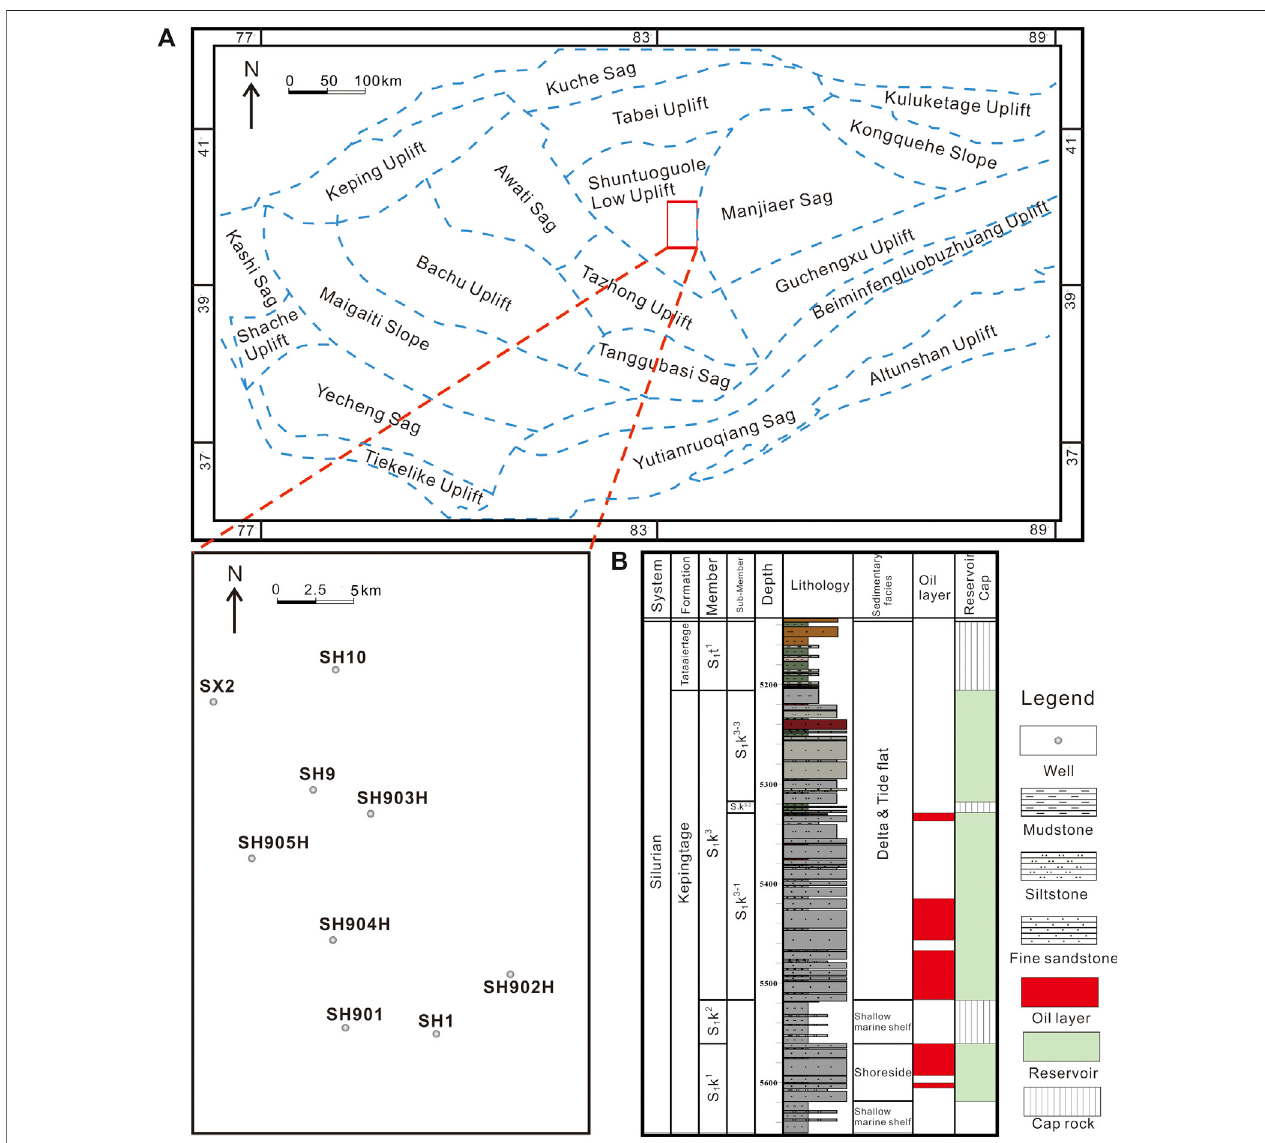
FIGURE 1 | Structural location and well location distribution in the study area. (A) Location of Shuntuoguole low uplift and surrounding structural features. (B) Lithological pro fi le and reservoir-caprock assemblage of Kepingtage Formation (S 1 k 1 , totally 90 ～ 150m thick shoreside (non-barrier coast)-shallow marine shelf facies deposit that is different from common high-energy shoreside due to low-energy water body, mainly consists of fi ne-grain sandstone with medium-grain sandstone and siltstone in the upper part and mudstone in the lower part. S 1 k 2 , 43 ～ 59m thick, deposited in the shallow marine shelf. S 1 k 3 , 287 ～ 342m thick, depositing in delta (tidal action) depositional system, mainly consists of silt- fi ne sandstone interbedded with silty mudstones, with a 15 ～ 30m mudstone in its middle part. The three sandstone members, S 1 k 3-3 , S 1 k 3-1 , and S 1 k 1 , containing reservoirs with abundant oil and gas, form several favorable reservoir-cap assemblages in combination with S 1 k 3-2 , S 1 k 2 , and S 1 t 1